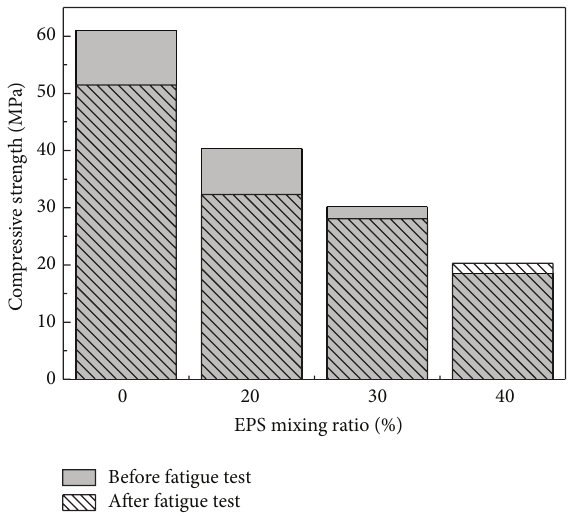
Figure 10: Later strength of 50 KN 50000-time cyclic